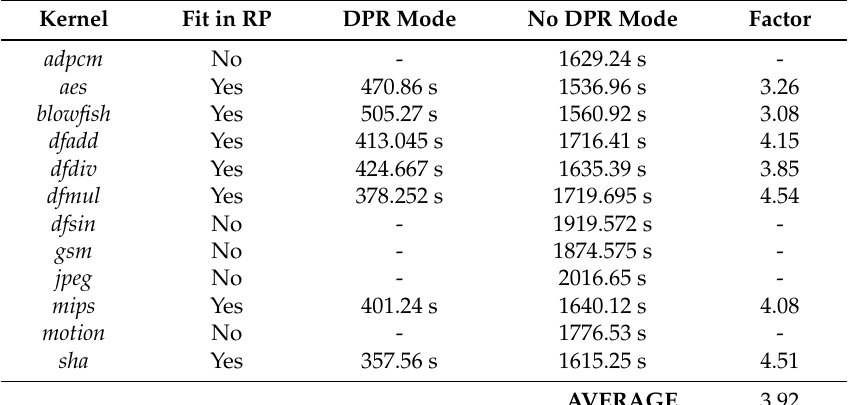
Table 4. Timing Savings.